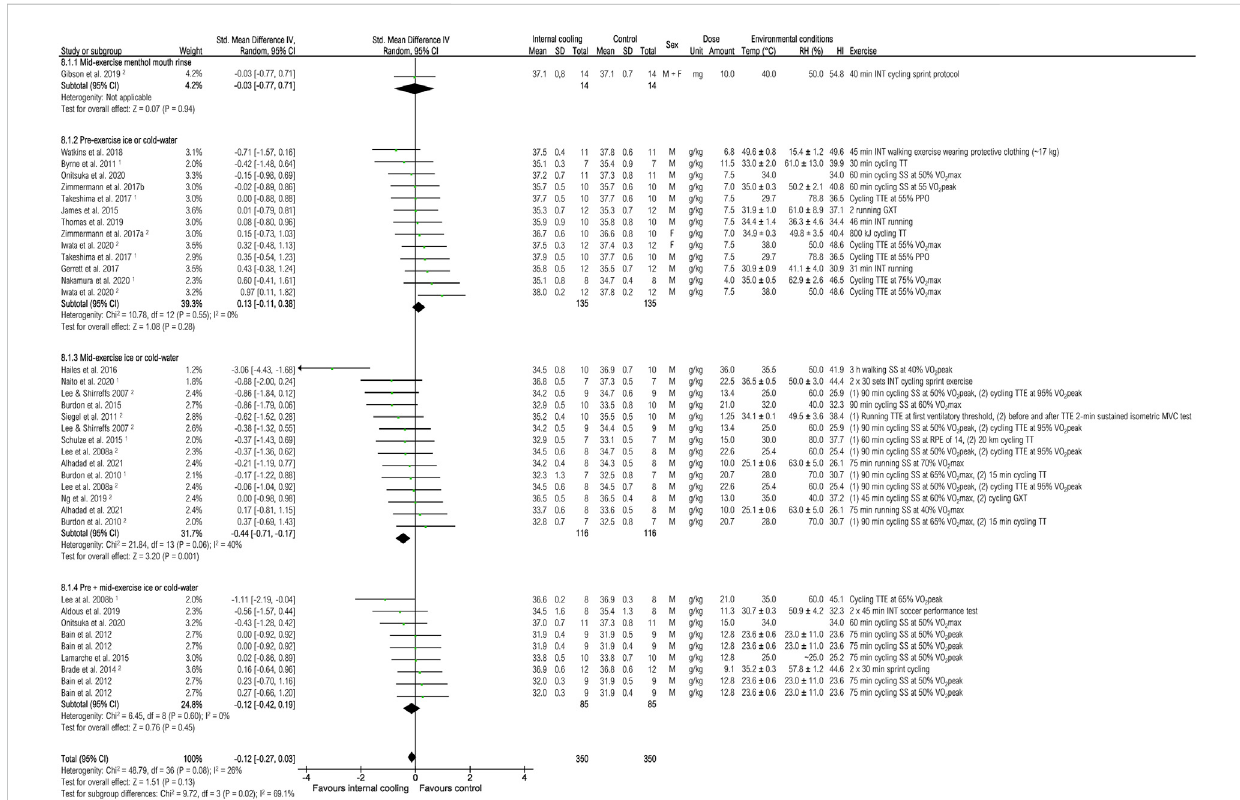
FIGURE 6 Meta-analysis of standardized mean difference in skin temperature [ ° C] with 95% CI between internal cooling and control. 1 Studies with signi fi cant positive performance effects of internal cooling. 2 Studies with no performance effects of internal cooling. F, female; GXT, graded exercise test; HI, heat index; INT, intermittent exercise; M, male; MVC, maximum voluntary contraction; PPO, peak power output; RH, relative humidity; RPE, rate of perceived exertion; SS, steady-state exercise; Temp, ambient temperature; TT, time trial; TTE, time to exhaustion; VO 2 max, maximum oxygen consumption; VO 2 peak = peak oxygen